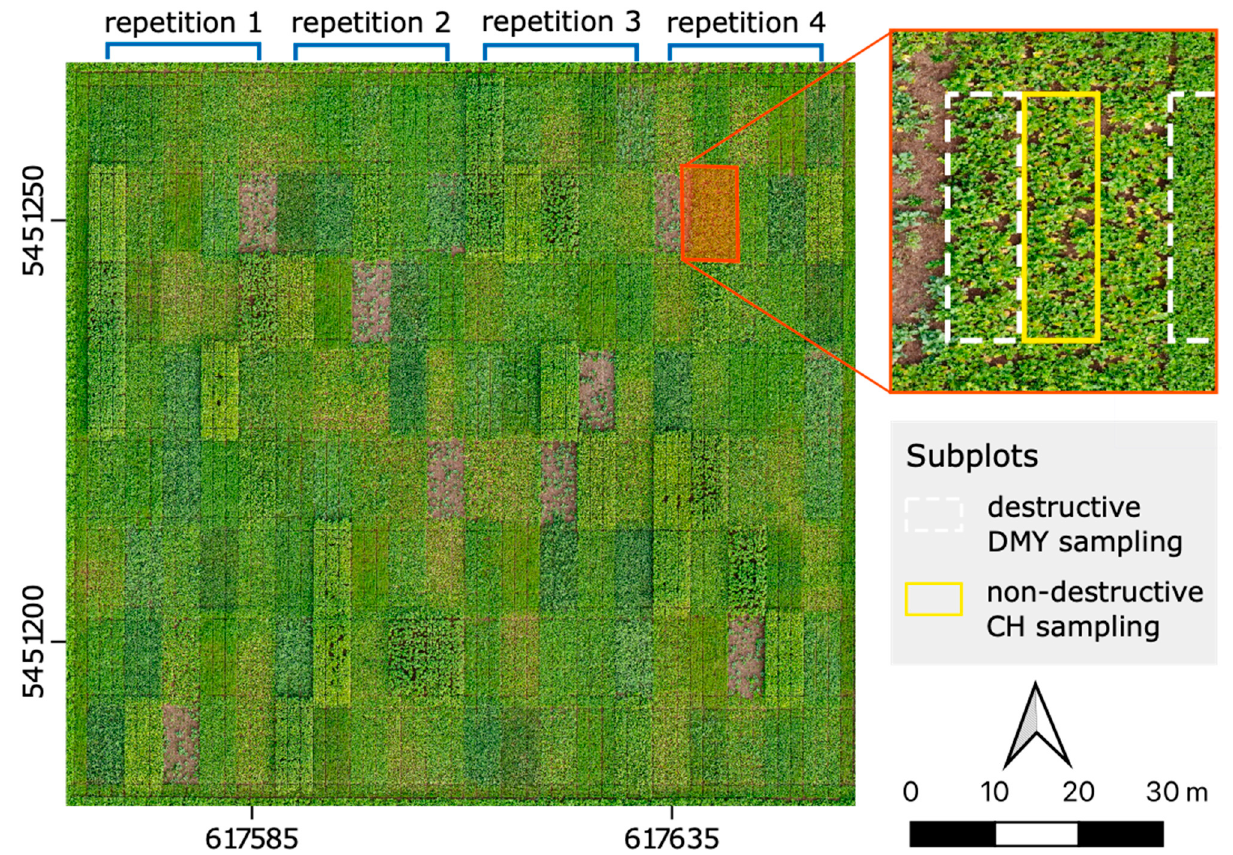
Figure 2. Aerial image of the cover-crop field trial indicating the repetitions and a scheme of the plots divided into subplots for destructive dry matter yield (DMY) sampling and non-destructive canopy height (CH) sampling. Table 1. List of cover-crop species and seed densities for pure stands. Cover-Crop